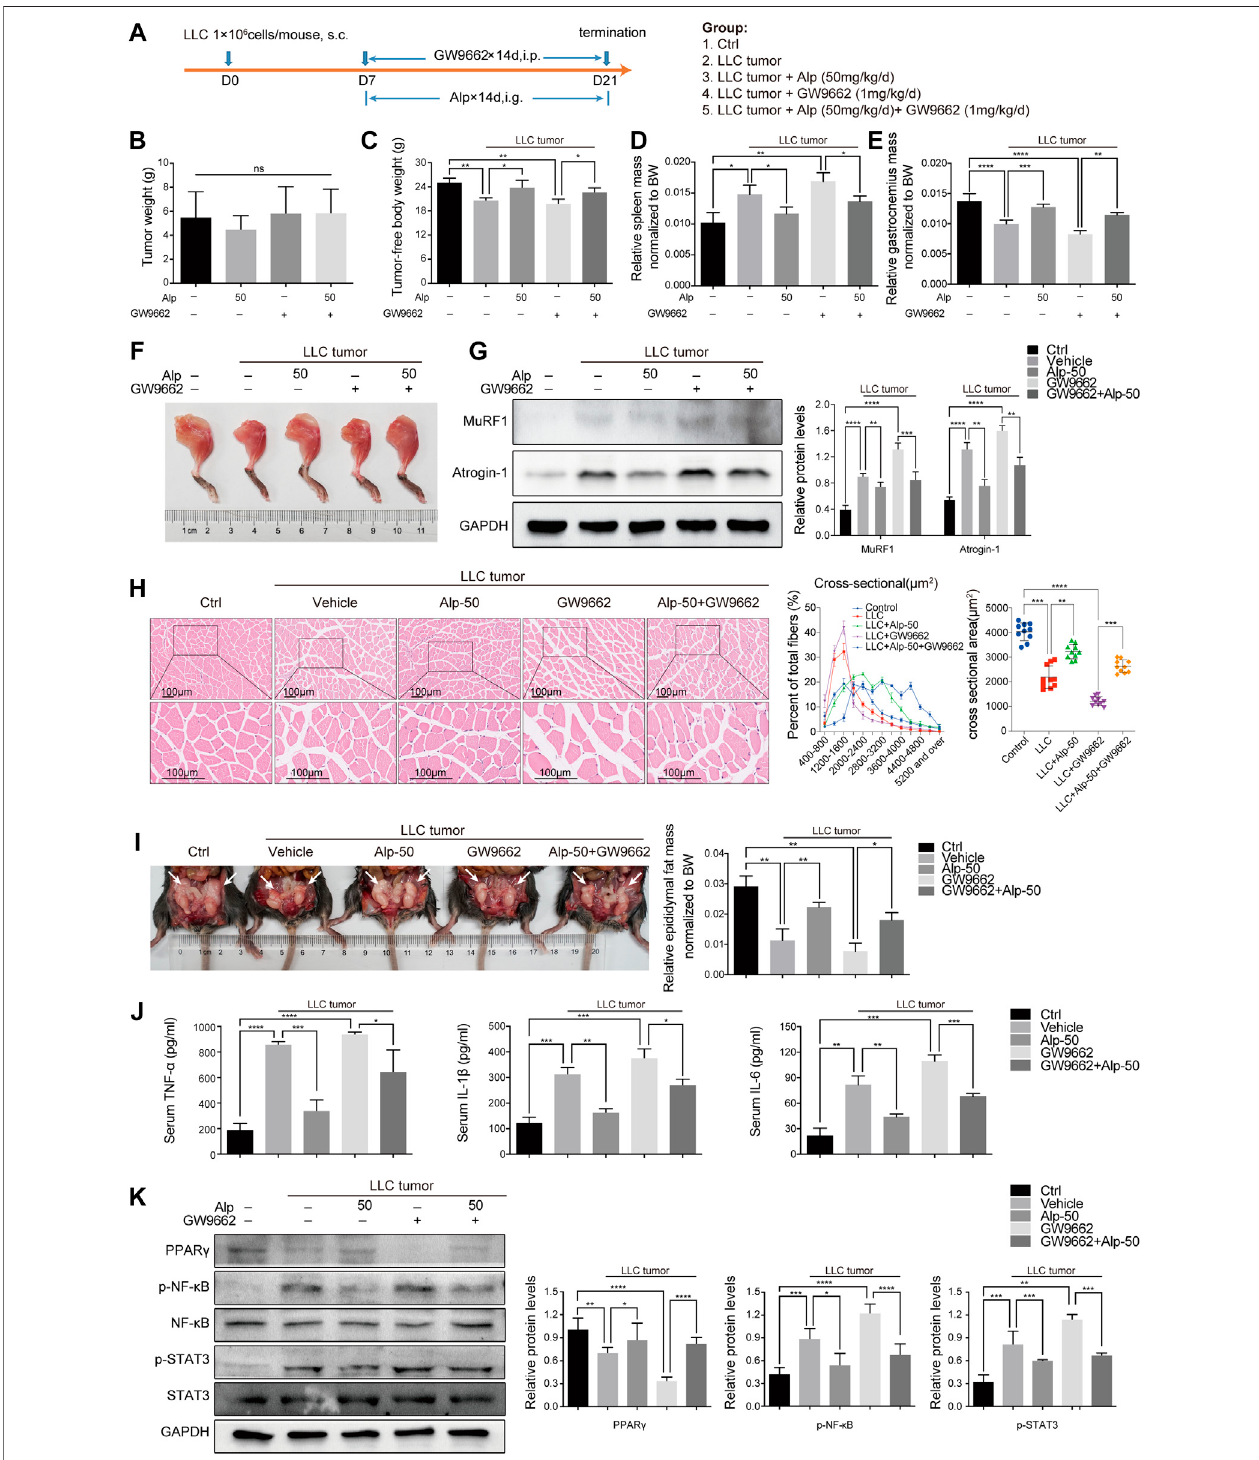
FIGURE 5 | Alp activates PPAR γ in muscles of LLC tumor – bearing mice. (A) Schematic presentation of the animal experiment protocol. Effects of PPAR γ on (B) tumor weight, (C) tumor-free body weight, (D) spleen mass, (E,F) gastrocnemius muscle mass, and (I) epididymal fat mass of LLC tumor – bearing cachexia mice were analyzed (BW: body weight). (G – K) The expressions of target proteins in gastrocnemius muscle were detected by Western blot, and the densities were calculated and normalized with GAPDH or the non-phosphorylated protein forms. (H) Gastrocnemius muscle atrophy was showed by HE staining and cross-sectional area analysis. (J) Pro-in fl ammatory cytokines of TNF- α , IL-1 β , and IL-6 were analyzed by ELISA in the serum of the animal model. * p < 0.05, ** p < 0.01, *** p < 0.001, **** p < 0.0001 vs. control. ns: not signi fi cant. n (cid:1) 10 mice/group.